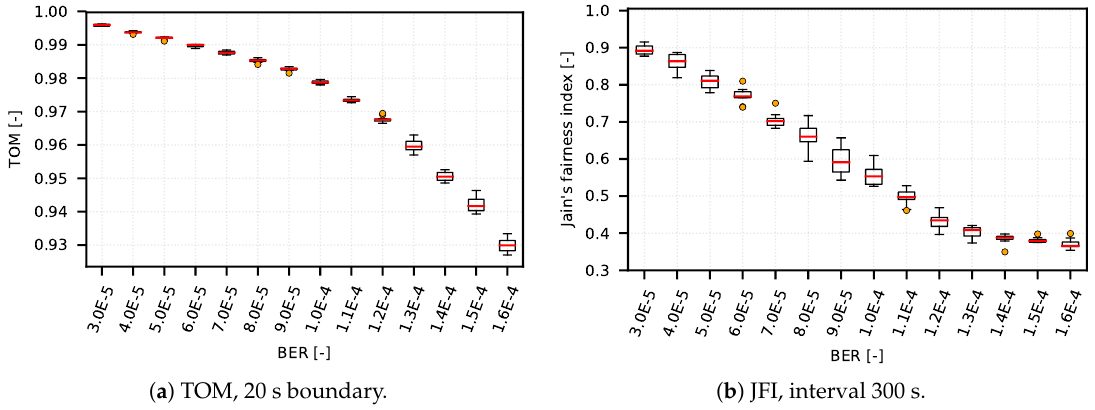
Figure 4. Scenario DumbBell, TOM and JFI comparison.